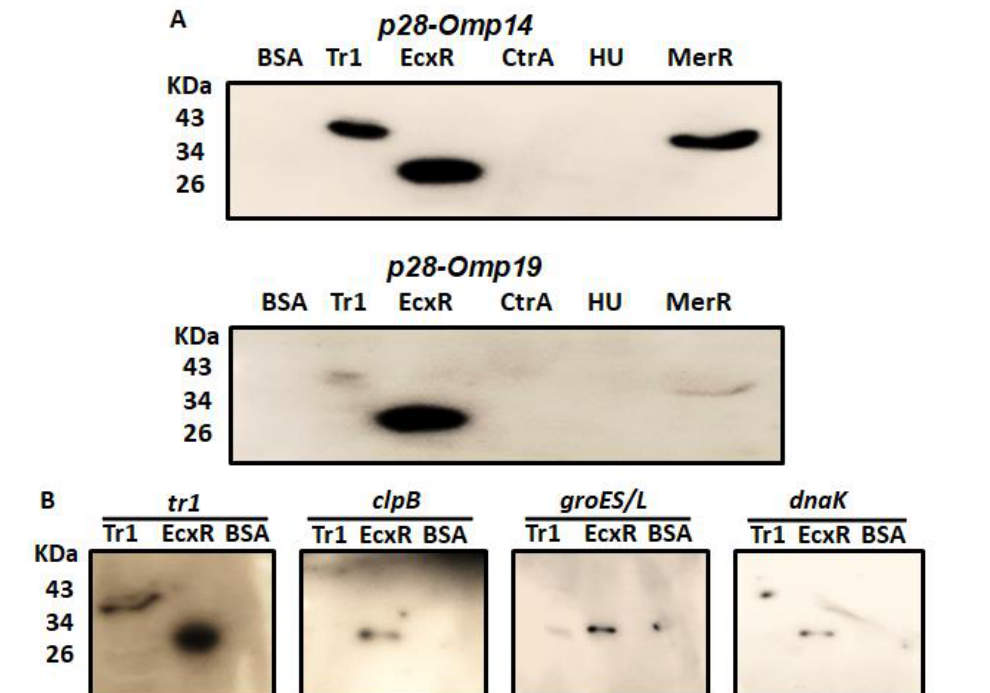
Figure 1. SouthWestern blotting for the promoters of E. chaffeensis with recombinant DNA-binding proteins. Recombinant DNA-binding proteins were purified and resolved in a 12% SDS-PAGE, transferred to a nitrocellulose membrane and then incubated with 32 P-labeled probes to visualize signals by autoradiography. BSA was used as the control non-specific protein control. ( A ) South- Western blot analysis to assess the interaction of Tr1, EcxR, CtrA, HU and MerR proteins with the full gene promoter segments of p28-Omp19 and p28-Omp14 . ( B ) Full promoters of E. chaffeensis genes, tr1 , clpB , groES/L and dnaK , were similarly subjected to the interactions with DNA-binding protein EcxR and Tr1.